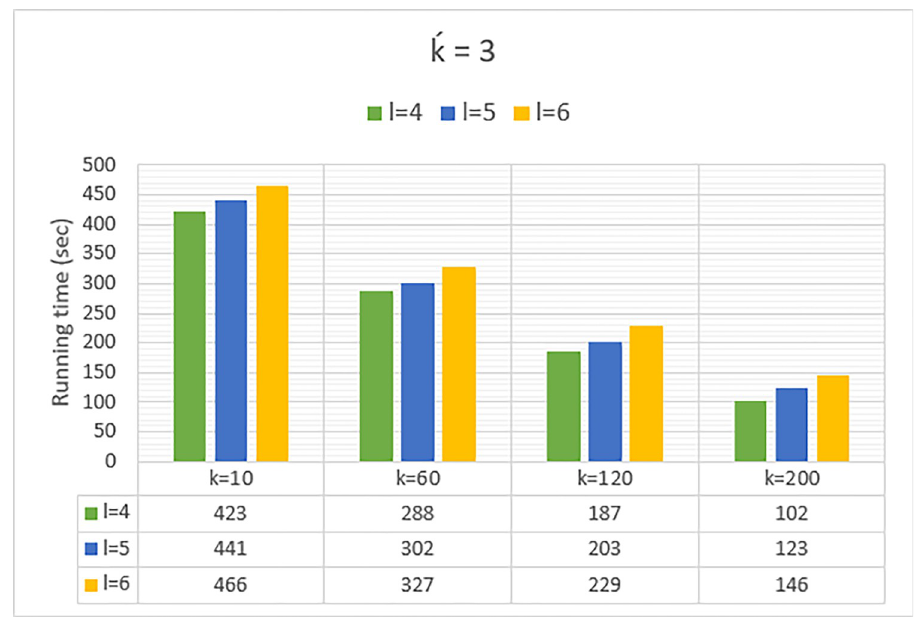
Fig 7. Runtime (sec) of the city block clustering on poker Hand dataset for k´ =